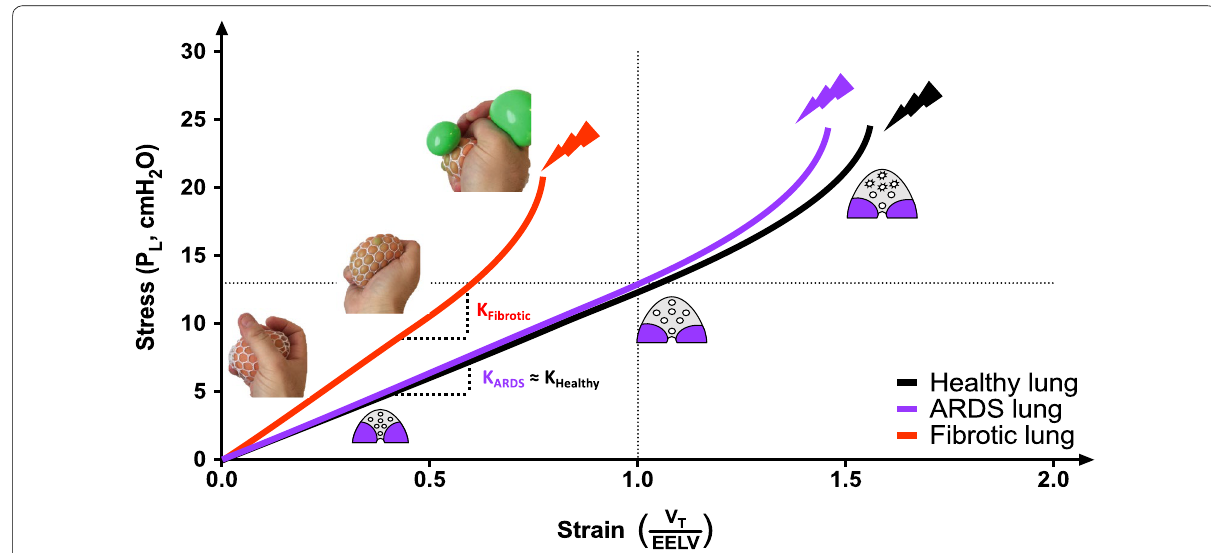
Fig. 1 Relationship between stress and strain in healthy, ARDS and fibrotic lungs. The specific elastance ( K ) is the slope of the curve in its linear portion. Although ARDS lungs are characterized by low compliance, its elastic properties follow those of healthy lungs provided that the deformation induced by tidal ventilation is normalized to the end-expiratory lung volume. In ARDS, the “baby lung” (gray area) inflates until a certain level where hyperinflation occurs and the linearity of the stress–strain relation is lost, approaching the breakdown limit of the extracellular matrix constituents (lightning). In fibrotic lungs, the specific elastance is higher thus the stress–strain curve is steeper. During inflation, the healthy regions protrude through the fibrotic walls, as illustrated by the hand progressively squeezing the “squishy ball”. Compared to ARDS, the breakdown is reached at lower stress and lower strain. ARDS acute respiratory distress syndrome, V T tidal volume, EELV end-expiratory lung volume, P L transpulmonary